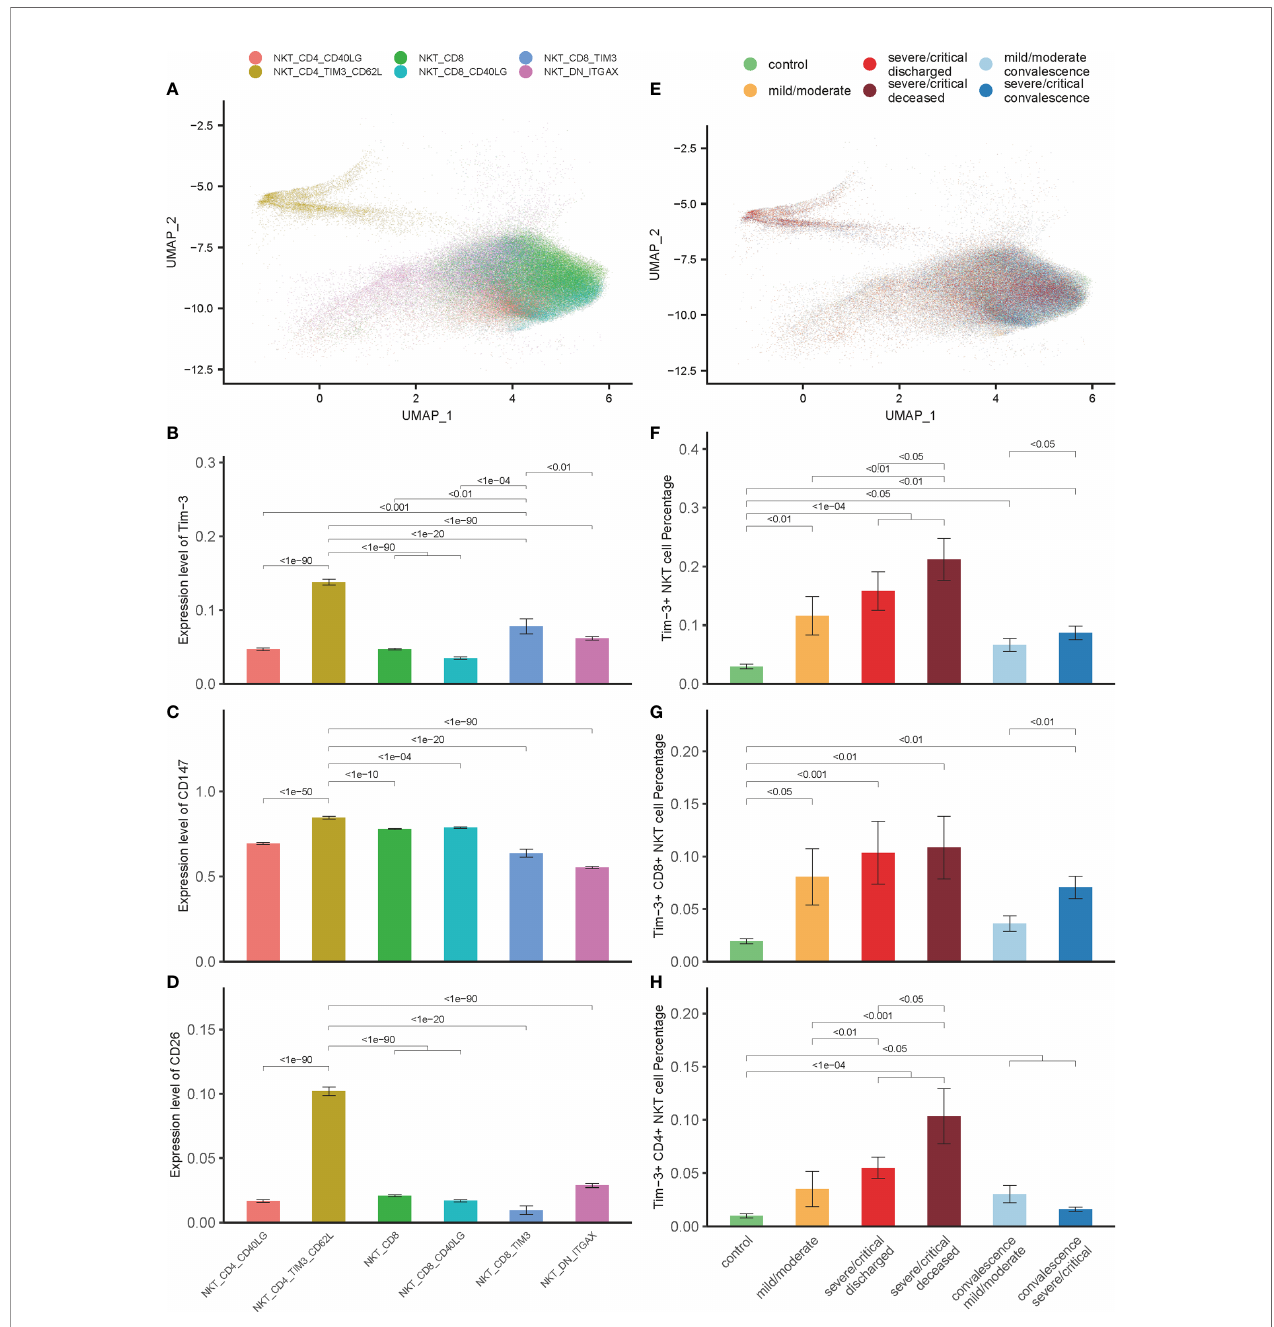
FIGURE 3 | Tim-3 expression in NKT cells associated with disease severity and outcome in COVID-19 patients. (A) Integration analysis results of NKT cells in COVID-19 patients and controls with 6 NKT cell clusters. (B) Expression of Tim-3 in 6 NKT cell clusters. (C, D) Expression of CD147 and CD26 in 6 NKT cell clusters. (E) Integration analysis results of NKT cells in COVID-19 patients and controls with no batch effect between samples. (F – H) Percentage of Tim-3+ NKT cells, Tim-3+ CD8+ NKT cells and Tim-3+ CD4+ NKT cells in COVID-19 patients and controls. (Wilcoxon